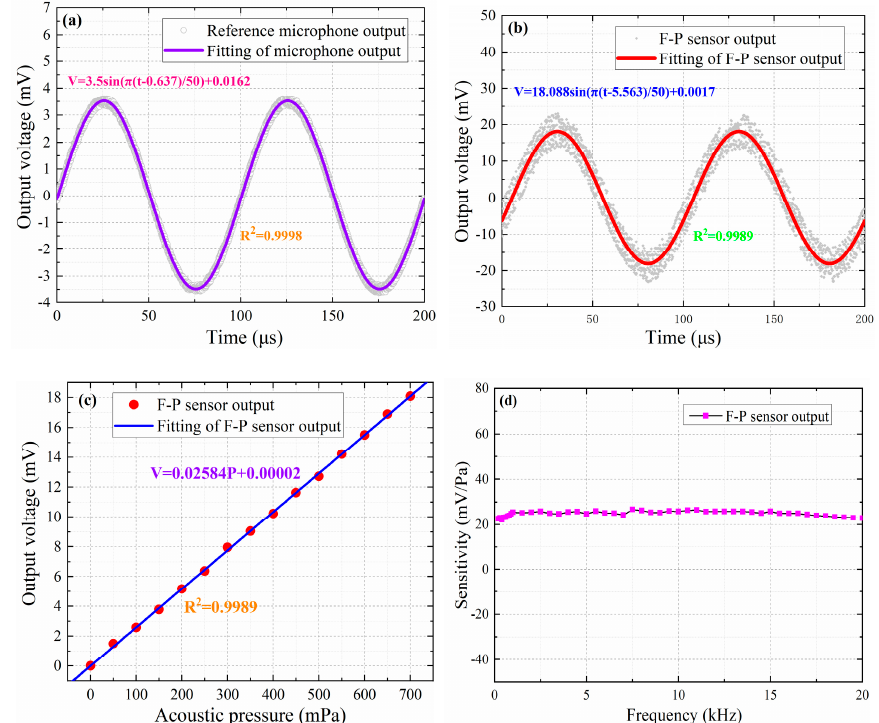
Figure 10. ( a ) Voltage signal output by the reference microphone at 10 kHz. ( b ) Voltage signal output by the proposed sensor at 10 kHz. ( c ) Acoustic-pressure response of the proposed sensor at 10 kHz. ( d ) Frequency response of the proposed sensor in the range of 200 Hz to 20 kHz.